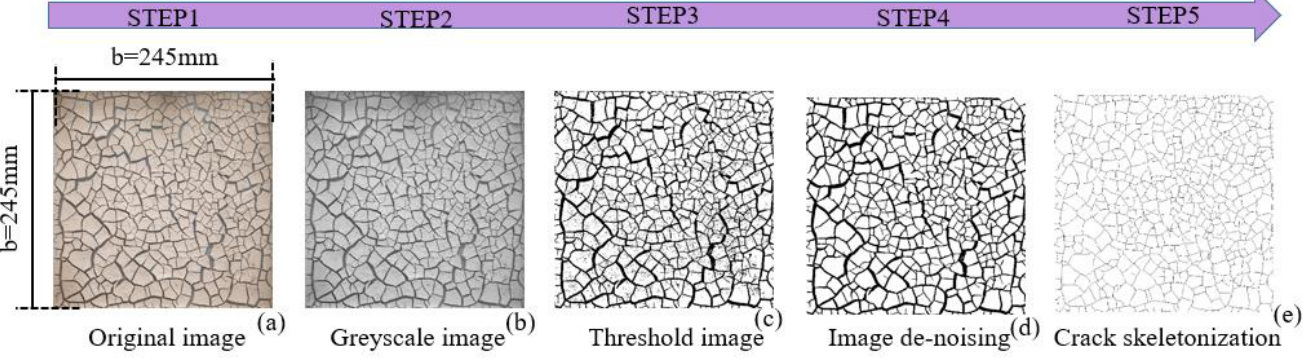
Figure 4. Image processing steps. The crack rate was defined as the ratio of the number of black pixels to the total number of pixels in the denoised binary image. Fractal theory was used to further describe the irregularity and complexity of the fracture network. The box dimension was used to calculate the fractal dimension, and the minimum number of grids covered the whole fracture area N ( k ) = 1/ k 2 . The lgN ( k ) − lg ( k ) double logarithmic coordinate plane was used for data processing in the fracture map, and the fractal dimension D could be calculated by calculating the slope of the fitting straight line [45]. The calculation formula for the fractal dimension is In the calculation formula, D is the fractal dimension; k is the side length of the grid; and N ( k ) is the number of